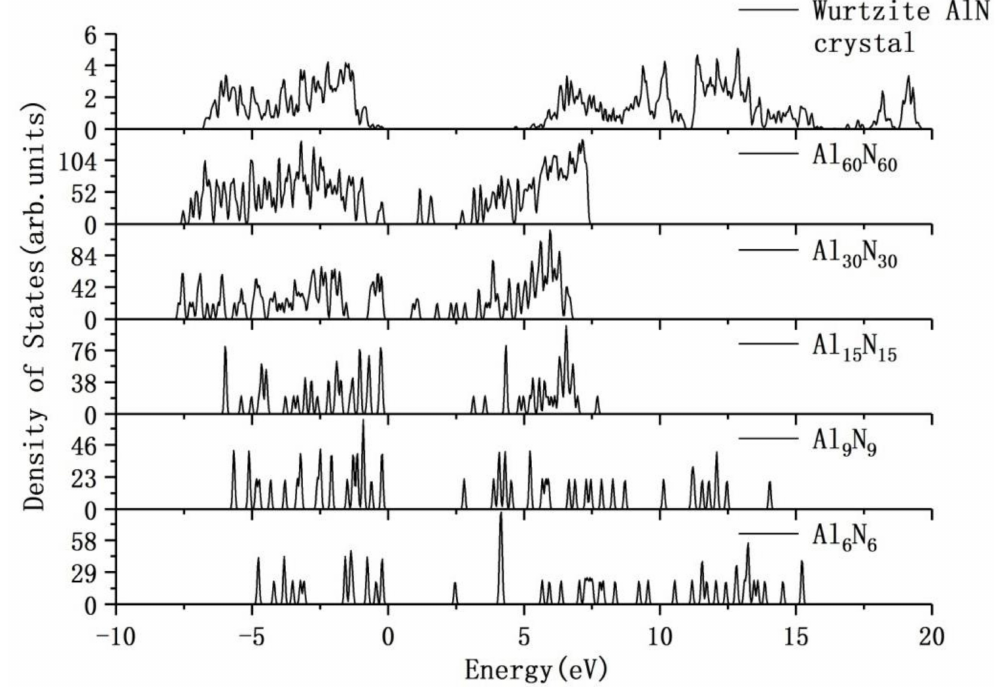
Figure 2. The electronic density of states of the Al 6 N 6 , Al 9 N 9 , Al 15 N 15 , Al 30 N 30 , Al 60 N 60 atomic clusters and the WurtziteAlN crystal through the HSE06 calculations (the Fermi level is set at